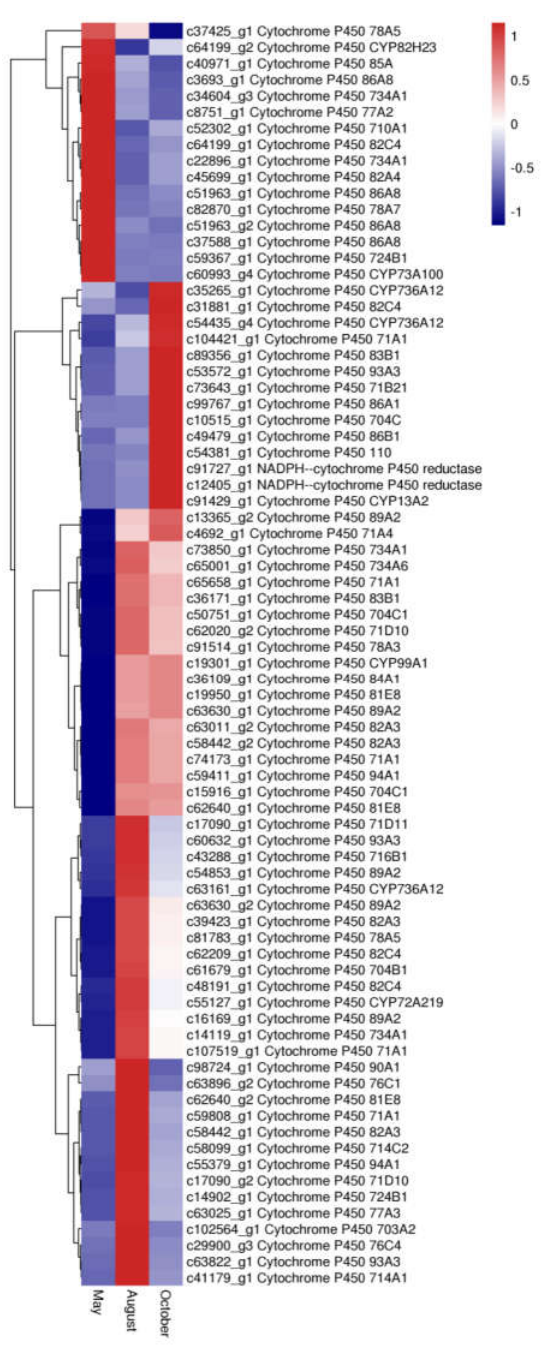
Figure 11. The expression level of DEGs of Cytochromes P450 in A. megalophylla . Blue and red colors represent different levels of gene expression, and the color scales reflect a log 2 -transformed mean of FPKM values.